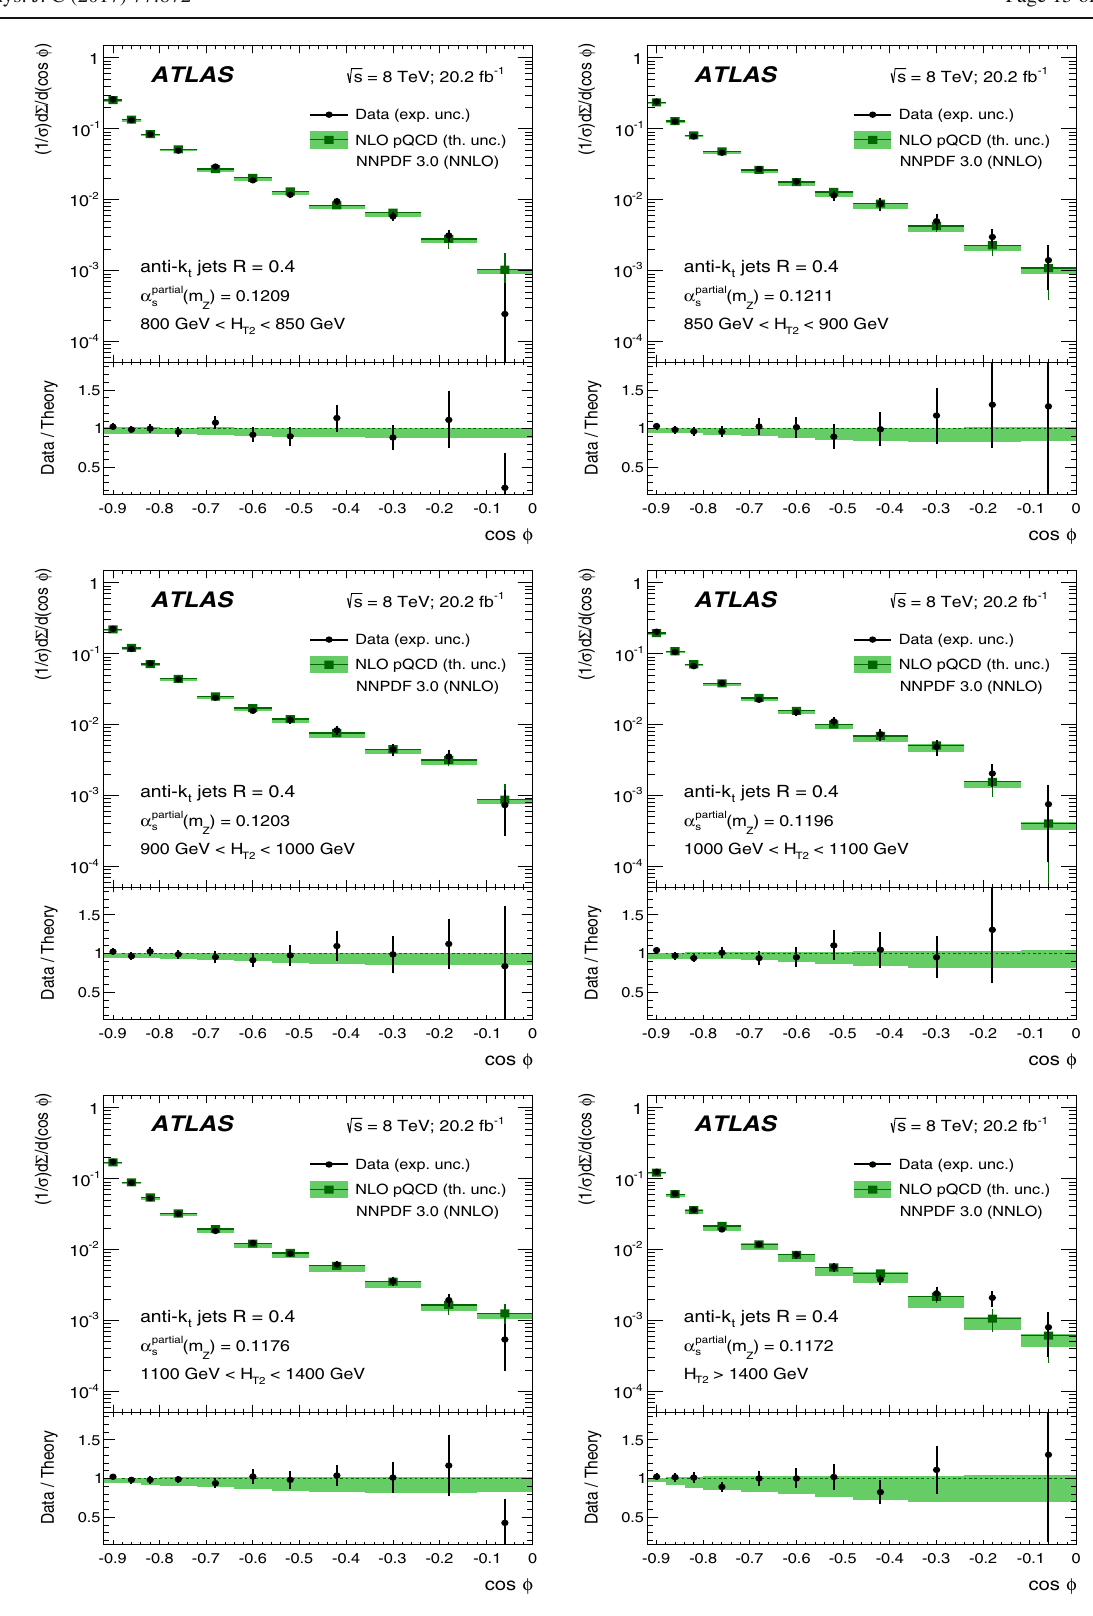
Fig. 10 Comparison of the ATEEC data and the theoretical predictions after the fit. The value of α s ( m Z ) used in this comparison is fitted independently for each energy